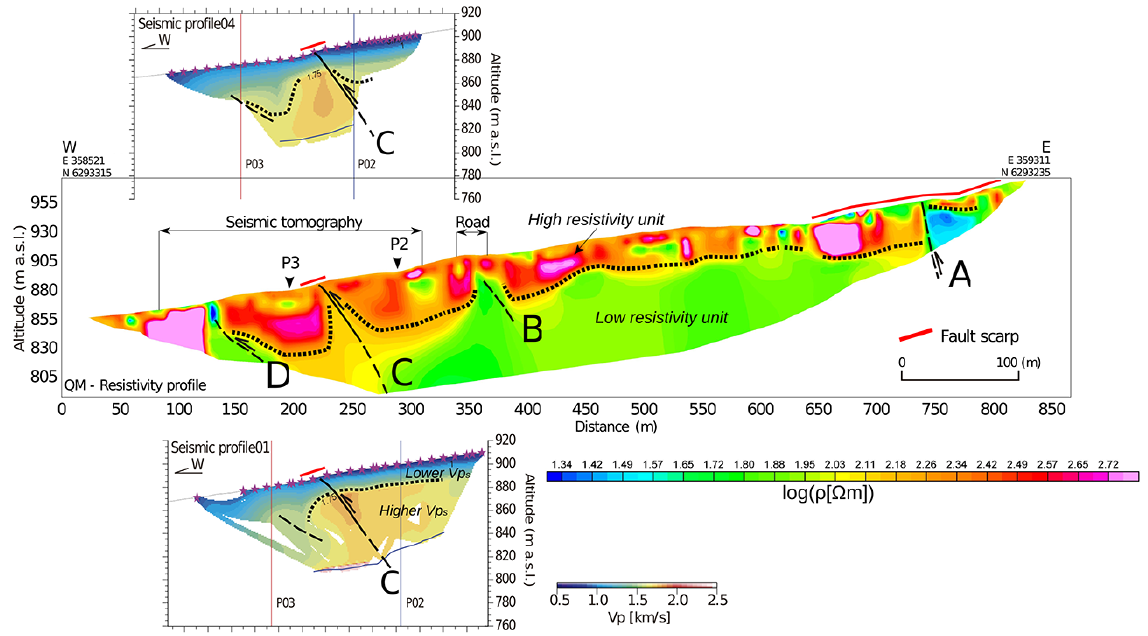
Figure 10. Inversion result close to along the Quebrada de Macul (L1) profile, including main structures interpreted in the text. Lower resistivity values at depth tend to remain on the eastern side of the profile. Note that the structure marked as A could be the same structure observed in both zones (see Fig. 9). Results from seismic profiles P01 and P04 have been added for comparison. See zoomed view of P04 together with a corresponding outcrop from ongoing paleoseismological studies in Fig.